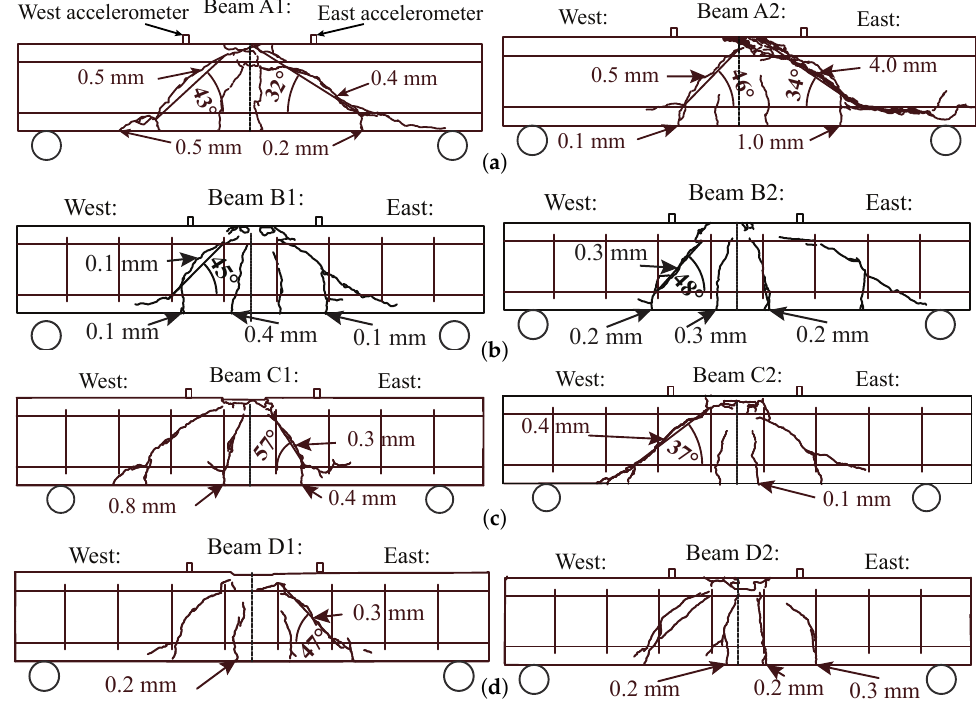
Figure 8. ( a ) Damage to A1 and A2 after the first impact; ( b ) B1 and B2; ( c ) C1 and C2; and ( d ) D1 and